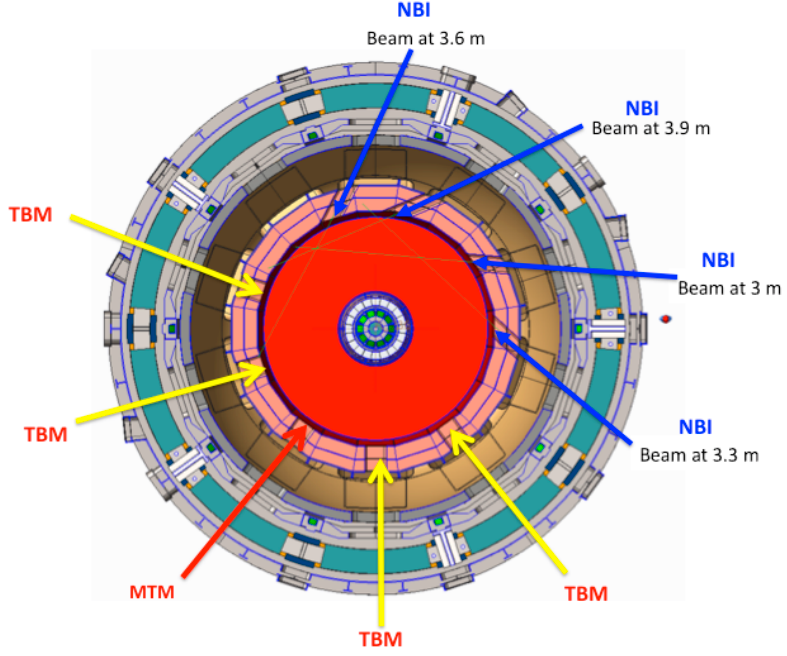
Figure 7. Midplane cross section though four TBMs, MTM, and heating and current drive ports of HTS ‐ FNSF.